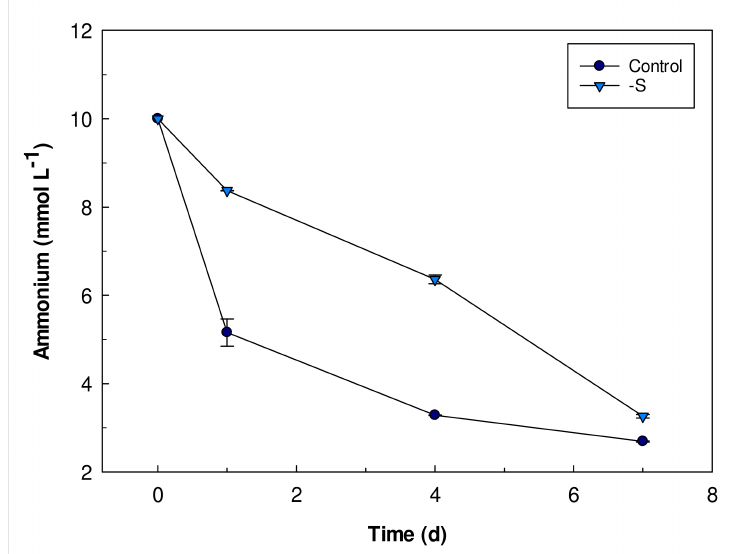
Figure 5. Ammonium content (mmol L − 1 ) in culture media of control and S starved (-S) cells. The residual ammonium in the cultures was estimated based on a Nessler method. Error bars represent SD ( n = 3).